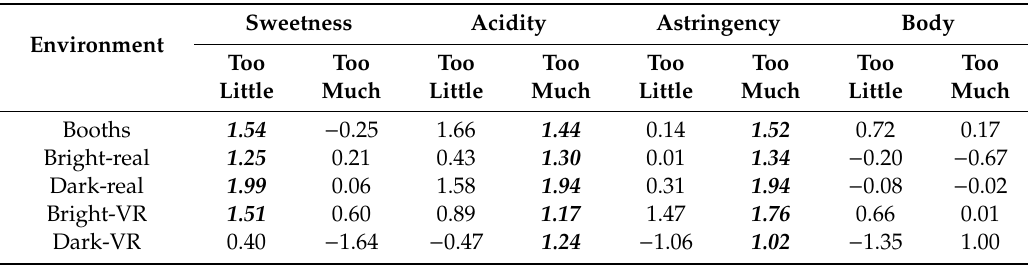
Table 3. Penalty analysis results for the sweetness, acidity, astringency, and body of the wine sample in di ff erent environments 1